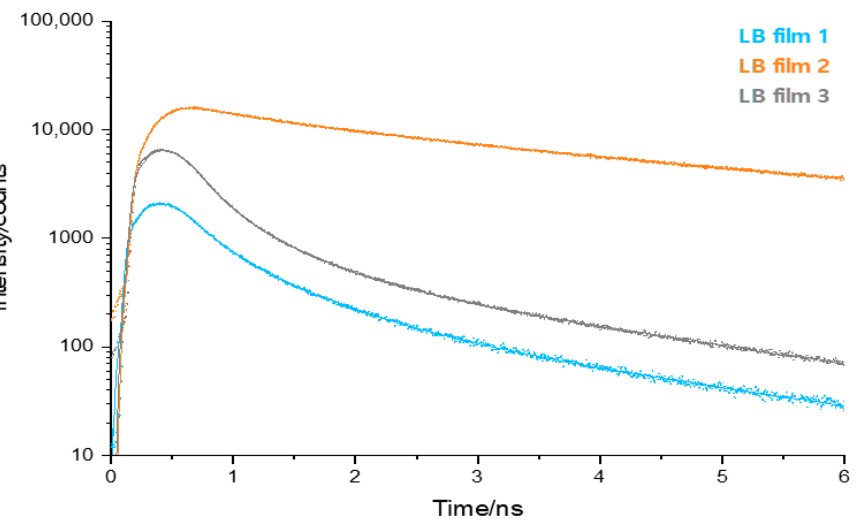
Figure 5. Time-resolved fluorescence microscopy decays for pristine (blank) LB films of 1 , 2 and 3 . Symbols are raw data and solid line is the fit. An IRF was used in the fitting procedure of the decays but not shown here. The fluorescence was detected using a long-pass filter ( λ em > 420 nm). The average lifetime data calculated from these decays can also be seen in Figure 6 (blank data set). For a breakdown of the individual decays into a sum of exponential terms, data can be found in the SI (Tables S1–S3). A different approach to the time-resolved fluorescence lifetime analysis is to examine the intensities via the integration of the fluorescence decay obtained in the fluorescence